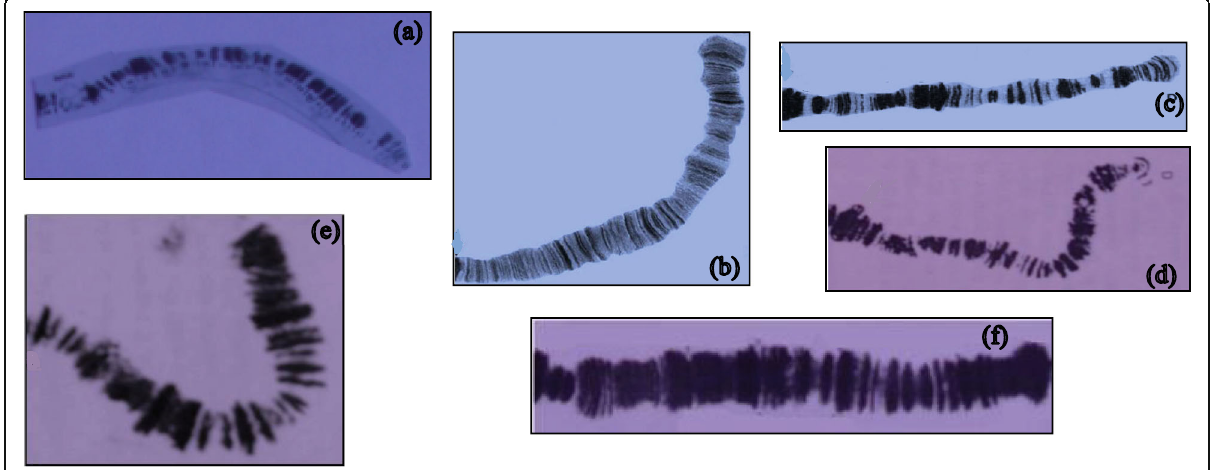
Fig. 5 Arm D of the polytene chromosomes of six species of Chironomus. a C. javanus. b C. dorsalis. c C. riparius. d C. matures. e C. maddeni.